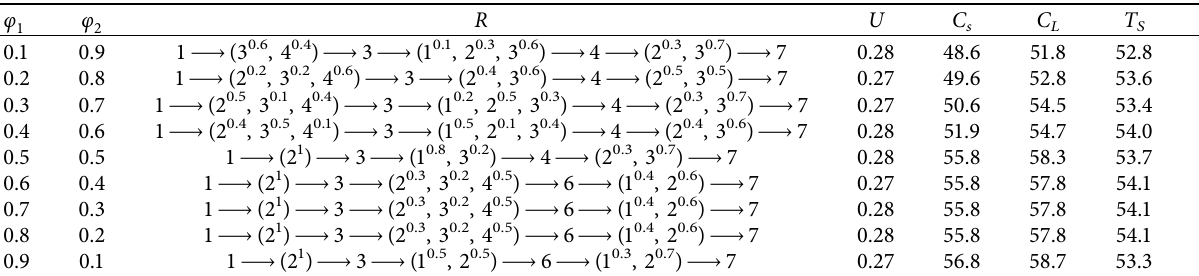
and φ on transportation plans. 1 2